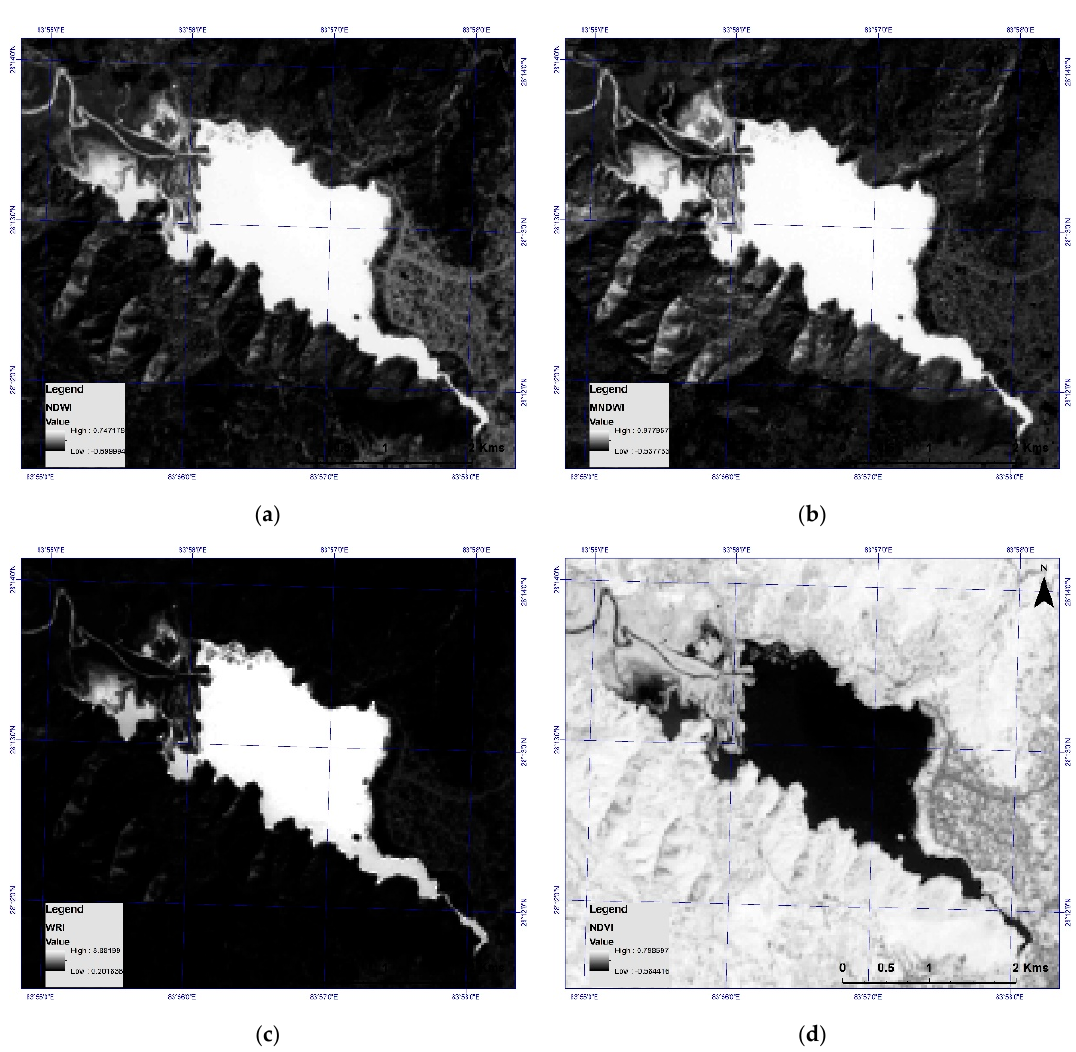
Figure 2. Water indices from Landsat 8 OLI image: ( a ) NDWI; ( b ) MNDWI; ( c ) WRI; ( d )